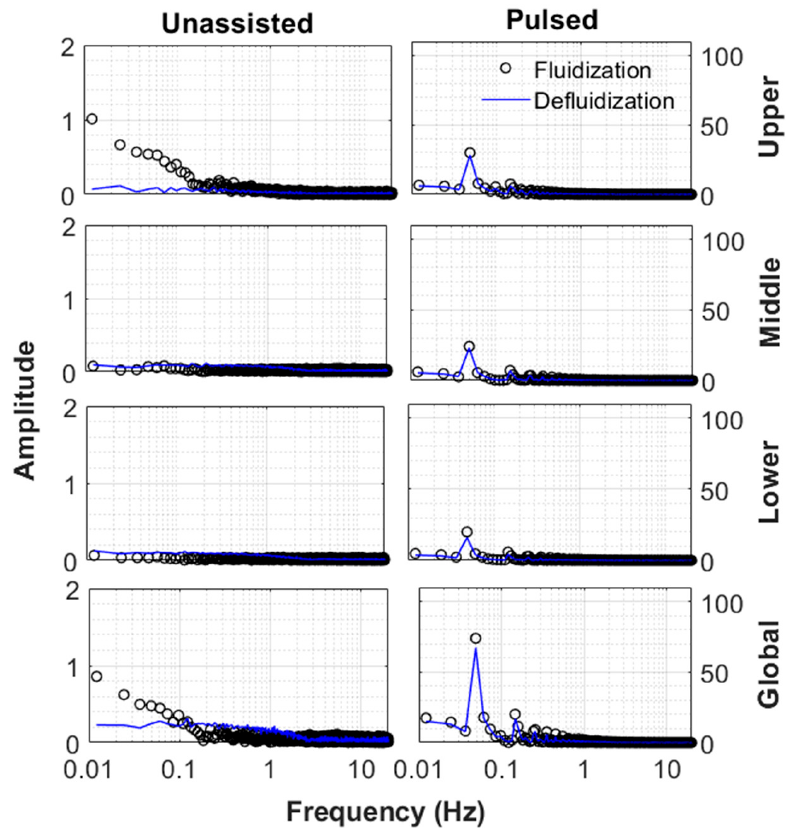
Figure 18. Frequency response of different regions of the bed at 12 mm/s for both unassisted and fluidization.